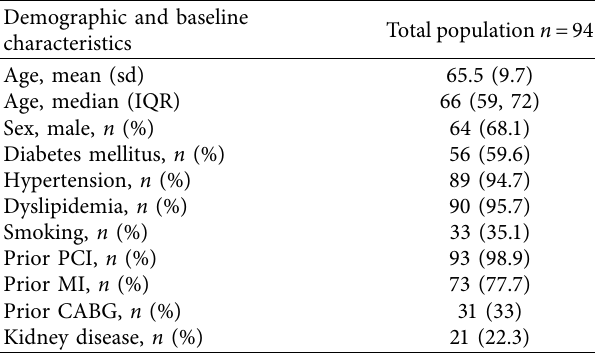
Table 1: Demographic and baseline characteristics.